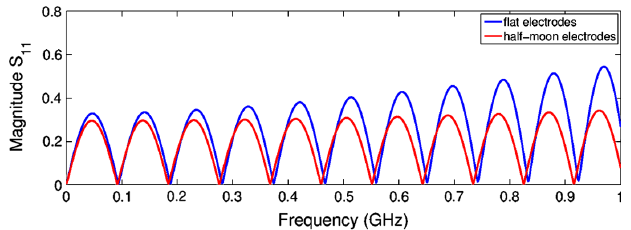
FIG. 9. S 11 looking into an input port, when the corresponding output is terminated with 50 Ω , for flat electrodes (blue) and half- moon electrodes (red), for a frequency range from dc to 1